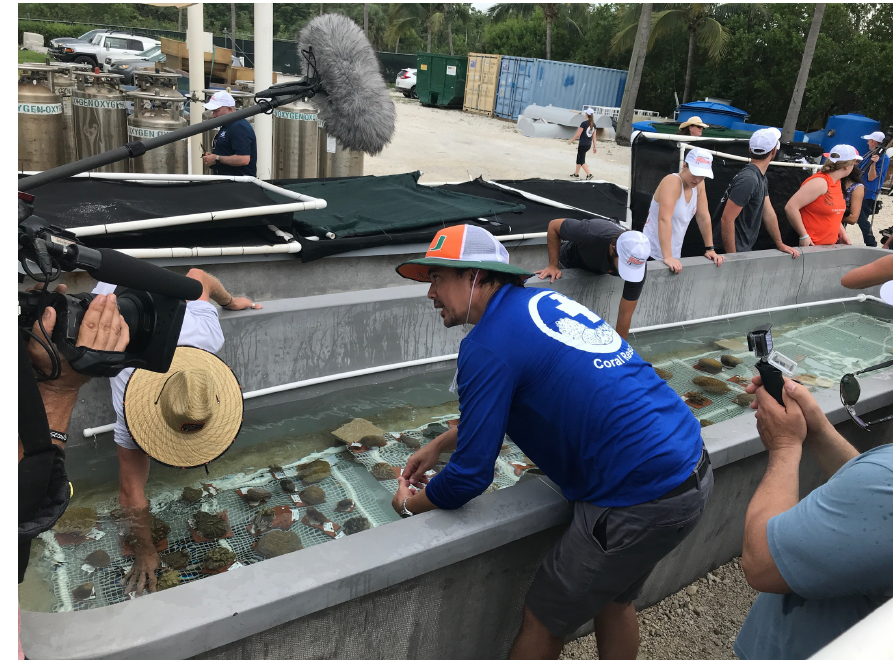
Figure 8: Image 2822. Photo by FWC Fish and Wildlife Research Institute, taken on July 5, 2019. Source: FWC Fish and Wildlife Research Flickr Account. NonCommercial-NoDerivs 2.0 Generic (CC BY-NC-ND